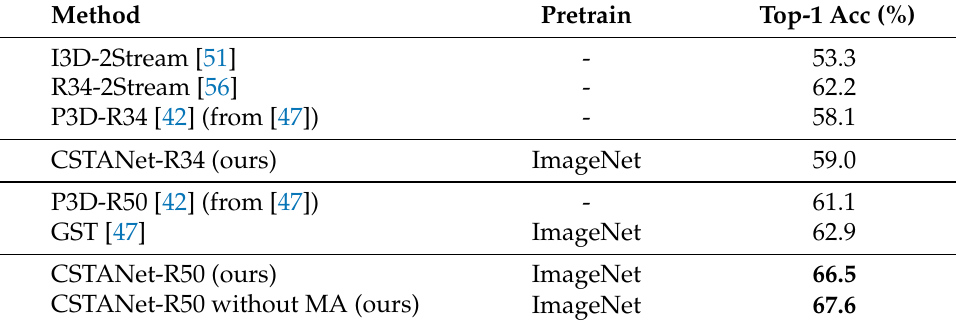
Table 6. State-of-the-art results on EGTEA